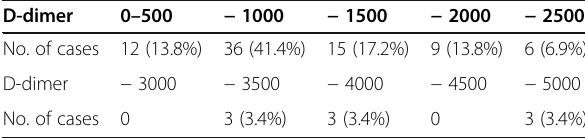
Table 2 Number of cases according different groups of serum